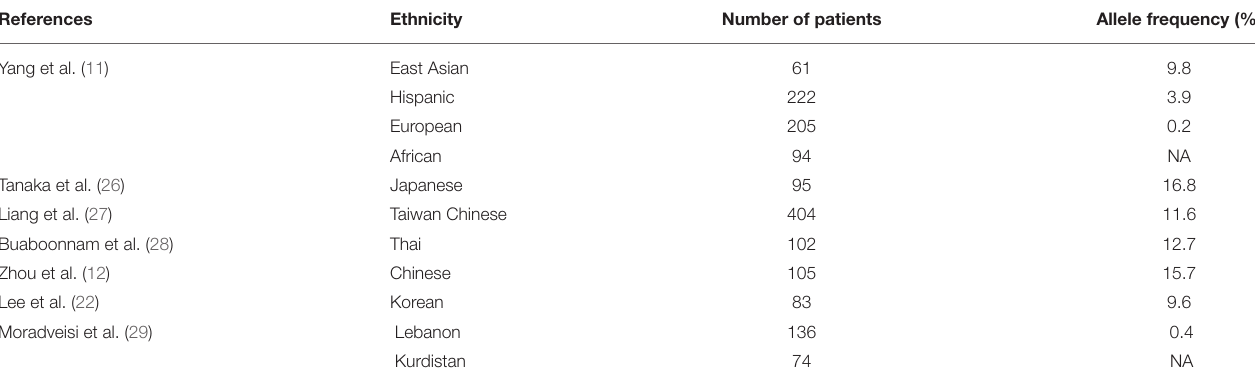
TABLE 3 | Frequency of NUDT15 c.415C > T (rs116855232) with ALL in different